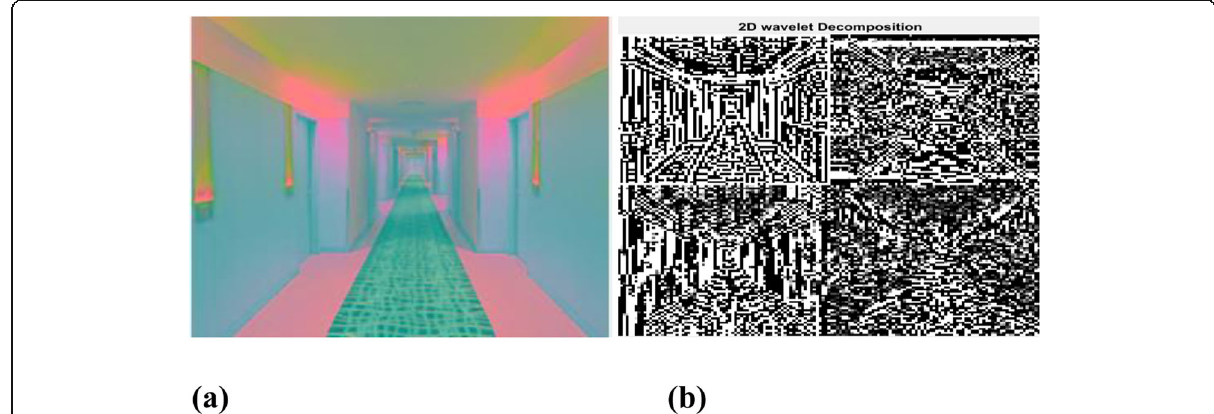
Fig. 4 Wavelet descriptors. a CIELAB color space image; b 2 dimensional wavelet decomposition